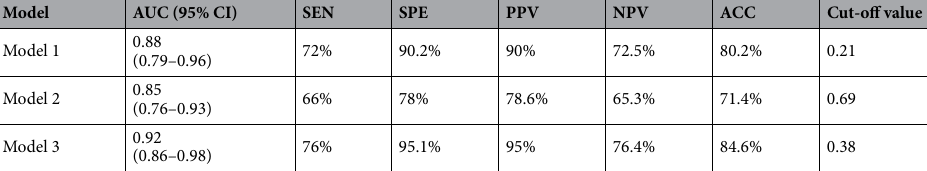
Table 5. The performance of three diagnostic models. Abbreviations: SEN sensitivity, SPE specificity, PPV positive predictive value, NPV negative predictive value, ACC accuracy.